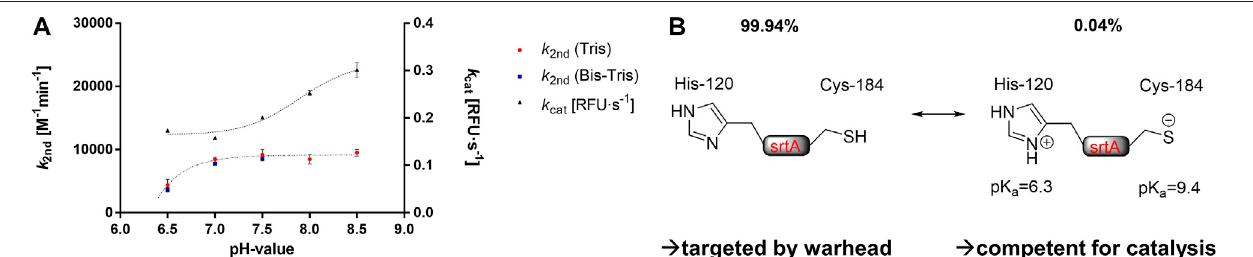
FIGURE 6 | Buffer effects on SrtA inhibition. (A) pH- and buffer dependence of the enzymatic activity [ k cat (RFU · s − 1 )] and the inhibitory potency of compound 5a [ k 2nd (M − 1 min − 1 )]. (B) Hypothesis for the covalent inhibition mechanism by sulfonylpyrimidines. The catalytically competent form presumably differs from the warhead- targeted form in terms of the protonation of the catalytic